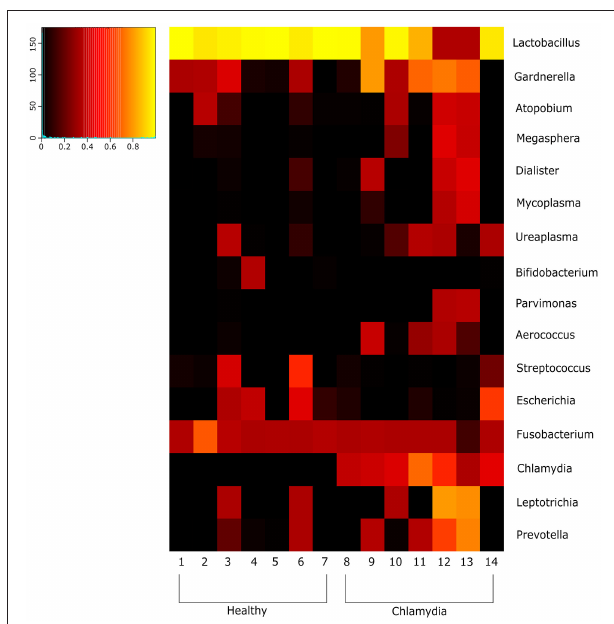
FIGURE 2 | Heatmap indicating the changes at the genus level of the cervical microbial composition in C. trachomatis positive women and healthy controls. The legend below the heatmap represents each participant. The relative abundance of bacteria in each genus is indicated by a color gradient from black (low abundance) to yellow (high